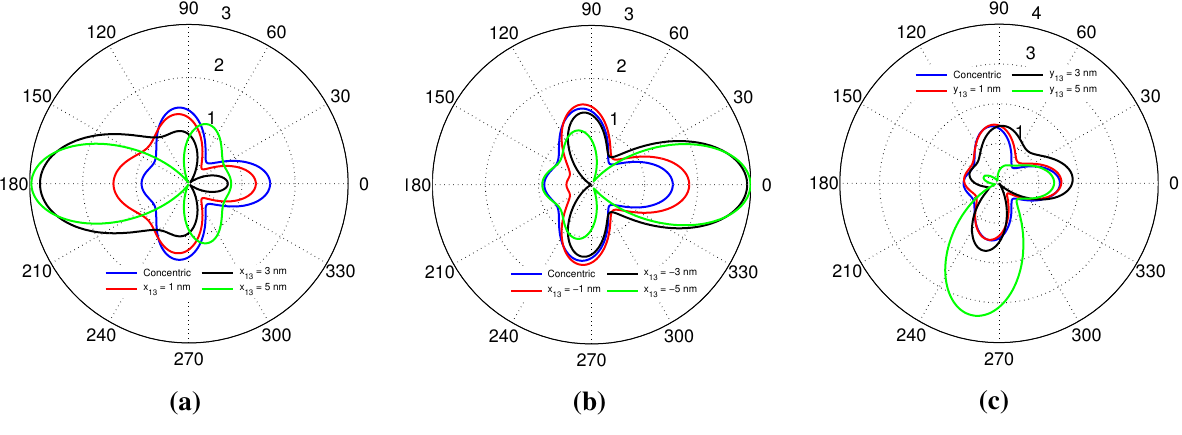
Figure 9. The directivity of the concentric and eccentric 3L NPs for κ = − 0 . 4409 at the shorter wavelength around 421 nm where the dipole and quadrupole modes are